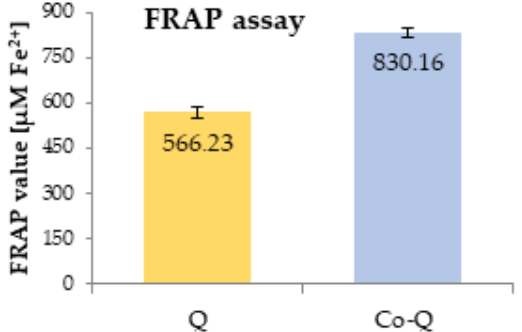
Figure 7. The FRAP values obtained for quercetin (Q) and Co(II) complex of quercetin (Co-Q). Mean values from three independent experiments ± SD are shown.